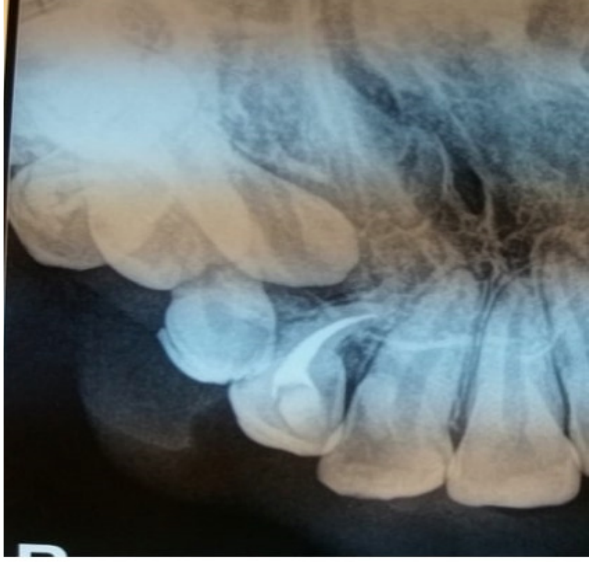
Figure 3: Upper occlusal radiograph after 3 months; root canal treatment completed, satisfactory osteogenesis around lateral